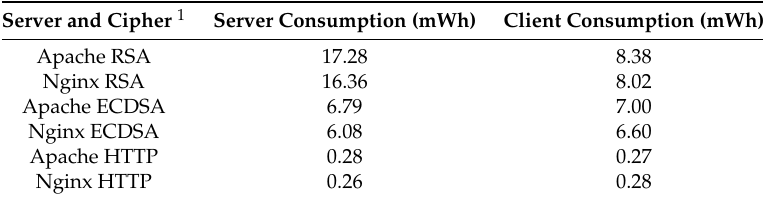
Table 5. Total energy consumption for a 512-byte payload for 32 concurrent clients. Client and server-side consumption for Apache and Nginx using Elliptic Curve Digital Signature